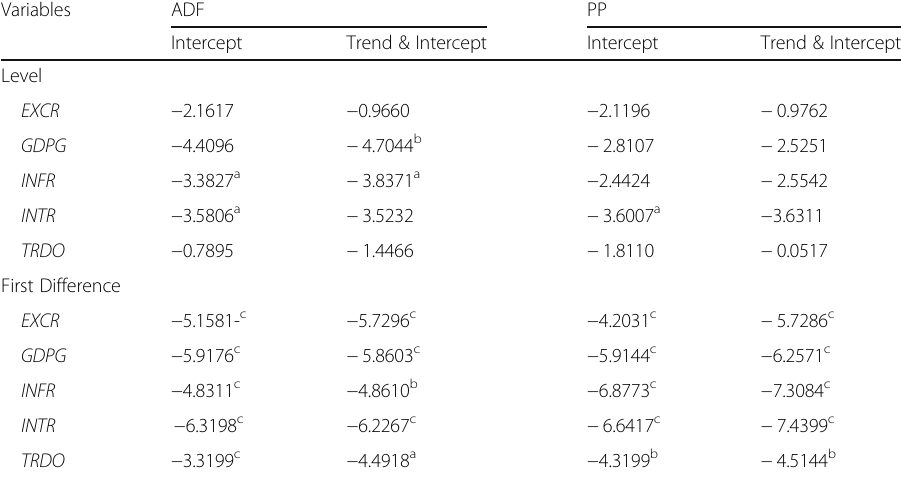
Table 1 indicates the results of the Unit Root test for checking the stochastic properties of the data are assessed on the basis of the series of each variable through Augmented Dickey Fuller and Phillips-Perron tests. Results indicate that inflation and interest rate are stationary at level with ADF unit root test, also interest rate is stationary at level with PP while the remaining variables are non-stationary at level. All the time series variables stationarity are again checked at the first difference with both ADF and